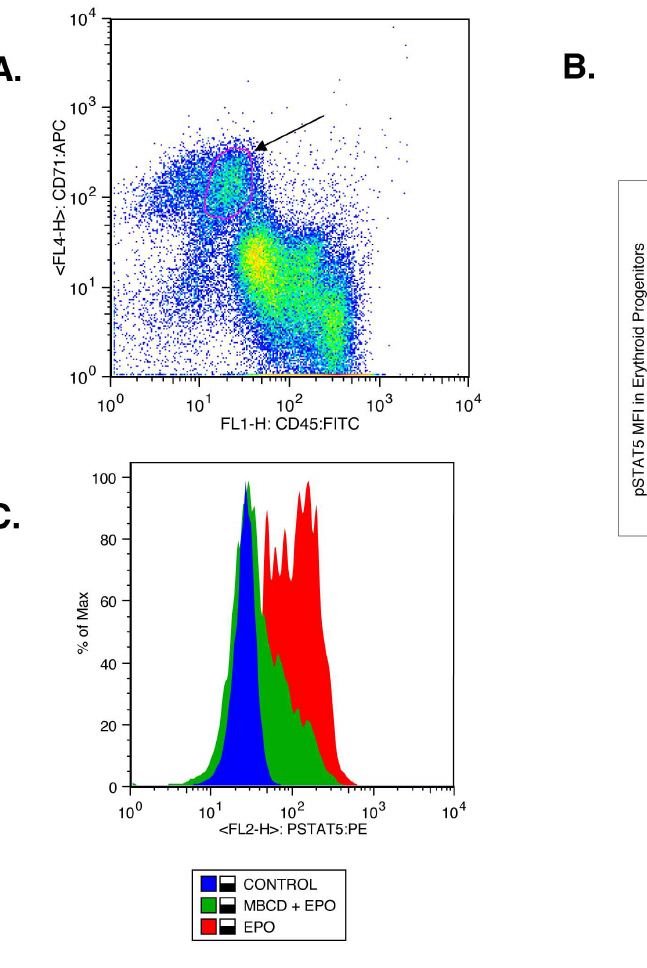
Figure 5. Cholesterol depletion attenuates Epo-induced STAT5 phosphorylation in primary erythroid progenitors. (A) Bone marrow mononuclear cells from a normal donor were isolated then stained with CD71:APC, CD45:FITC, and P-STAT5:PE. CD71 Hi /CD45 dim cells representing erythroid progenitors were gated. (B) Graphic comparison of geometric mean florescence intensities, mean 6 standard error from 3 independent experiments. (C) Representative flow histogram showing shift in phospho-STAT5 florescence intensity in primary erythroid progenitors treated with Epo with or without M b CD.